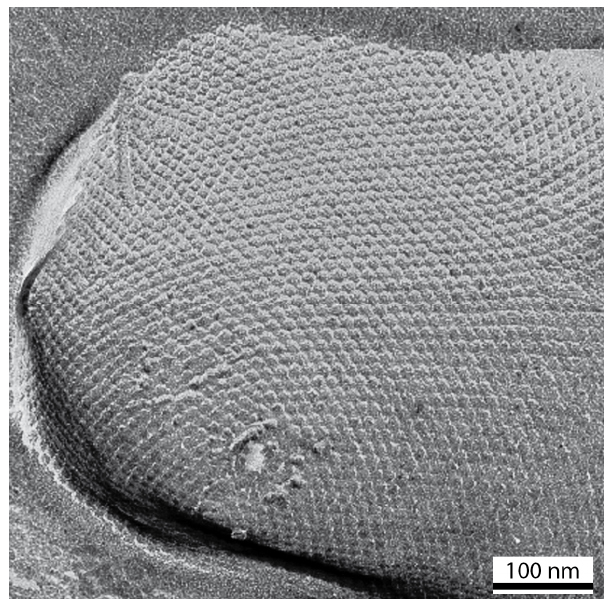
Figure 1. Transmission electron micrograph of a freeze-etched and metal shadowed preparation of an archaeal cell ( Methanocorpusculum sinense ) exhibiting an S-layer with hexagonal lattice symmetry